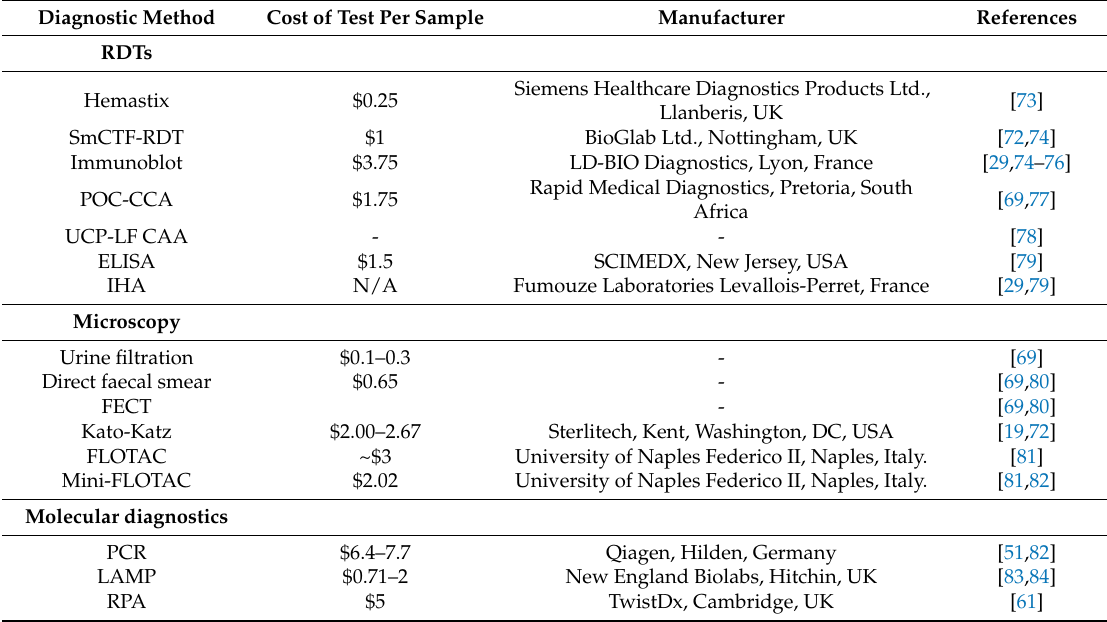
Table 1. Summary of Available Schistosomiasis Diagnostic Techniques, their Costs, Commercial Availability, and